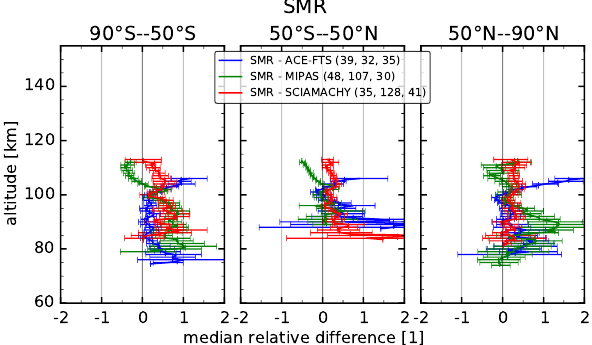
Figure 7. NO vertical profile comparison of the SMR data n SMR See Fig. 5 for details.